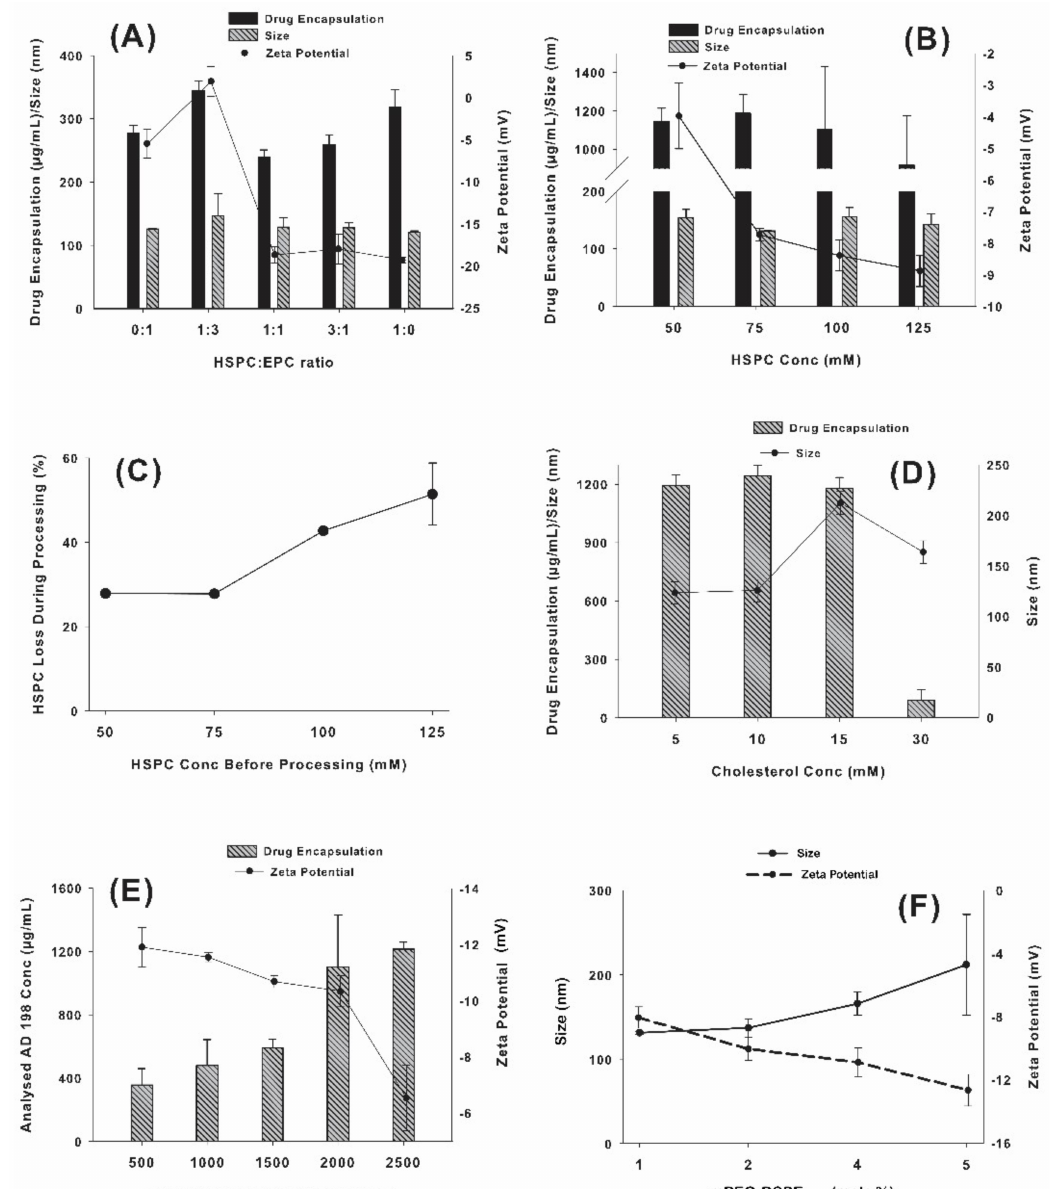
Figure 3. ( A ) Effect of lipid composition on AD 198 encapsulation and liposomal size; ( B ) Effect of total phospholipid concentration on liposome size, ζ -potential and AD 198 encapsulation; ( C ) Optimization of HSPC concentration; ( D ) Effect of cholesterol concentration on AD 198 encapsulation and liposome size; ( E ) Effect of AD 198 concentration on AD 198 encapsulation and ζ -potential; and ( F ) Effect of mPEG2000-DSPE concentration on ζ -potential and liposome